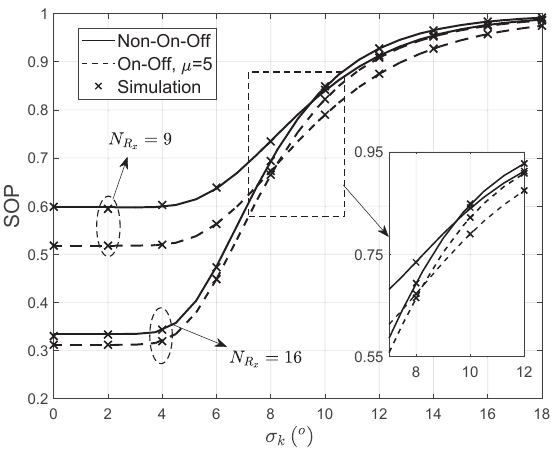
Figure 7. The SOP versus the eavesdropper density λ E when P t = 30 dBm, H = 120 m, C th = 4, C s = 1, λ U = 5 × 10 − 4 , and λ E = 1.5 × 10 − 3